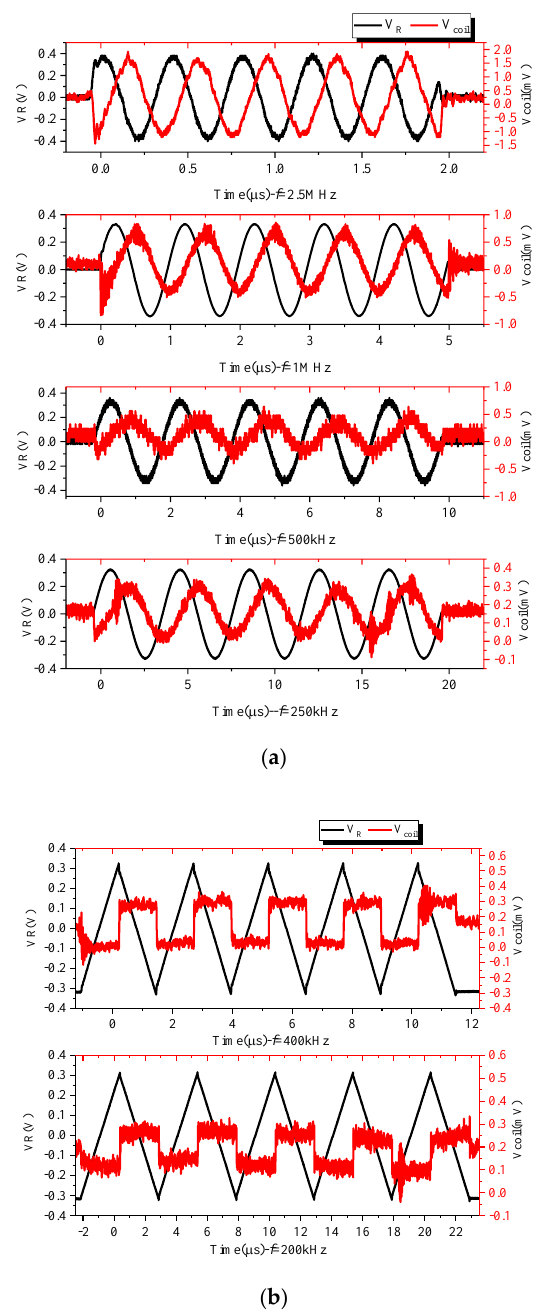
Figure 10. Roche coil differential relationship verification: ( a ) 2.5 MHz, 1 MHz, 500 kHz, 250 kHz sinusoidal and Rogowski coil outputs; ( b ) 400 and 200 kHz triangular wave and Rogowski coil outputs. The coil and integrator were connected by a coaxial cable of 100 pF/m, and the frequency characteristics of the Rogowski coil sensor were obtained by simulation, as shown in Figure 11.